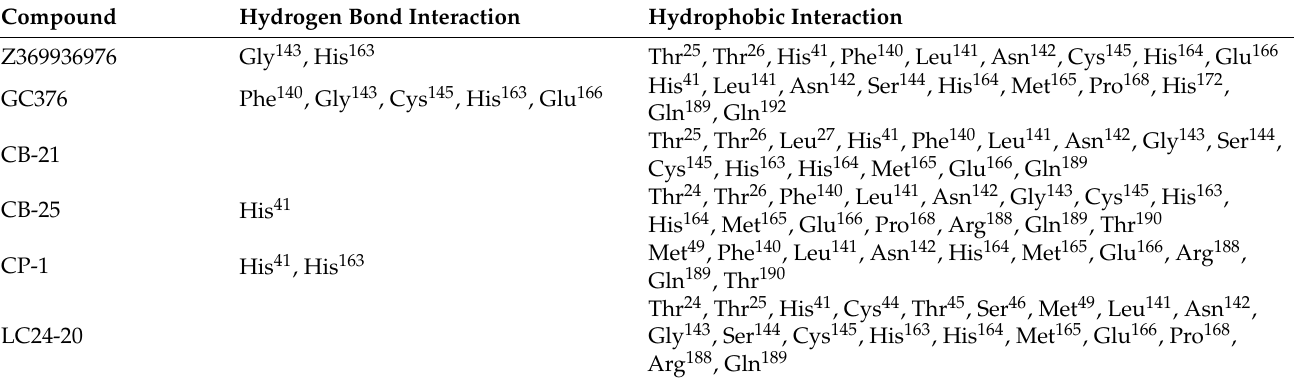
Table 3. Hydrogen bond and hydrophobic interactions between each compound and main